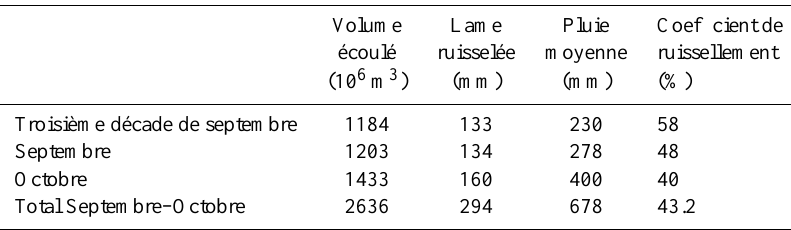
Tableau 2. Caractéristiques hydrométéorologiques des événements de l’automne 1969 pour l’oued Zeroud à la station de Sidi Saad (Cruette et al.,